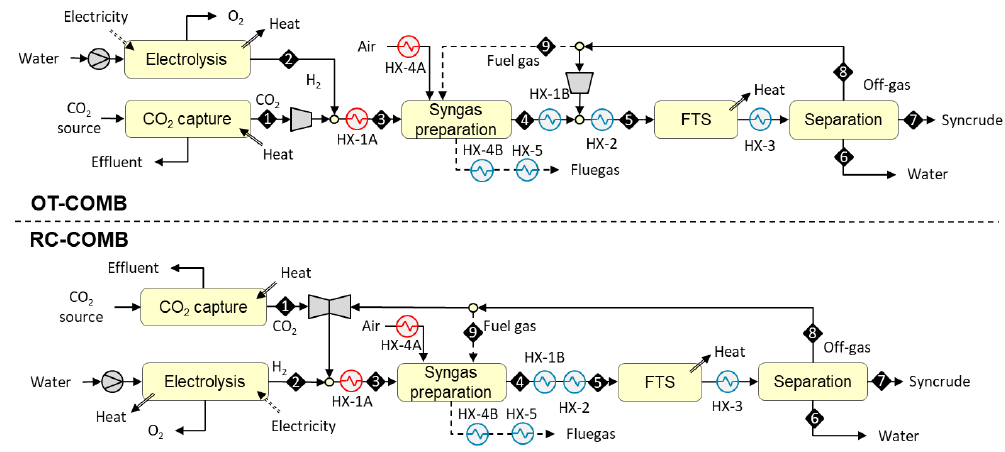
Figure 2. Block diagrams for the OT-COMB and RC-COMB configurations based on allothermal heating from combustion.